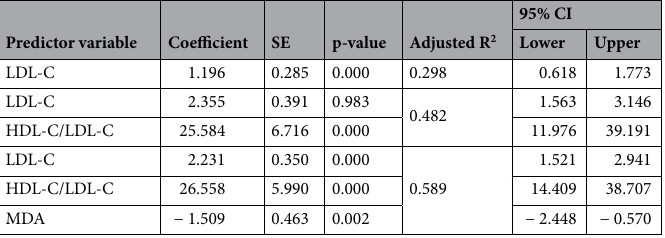
Table 7. Multiple regression analysis using GSH levels as the dependent